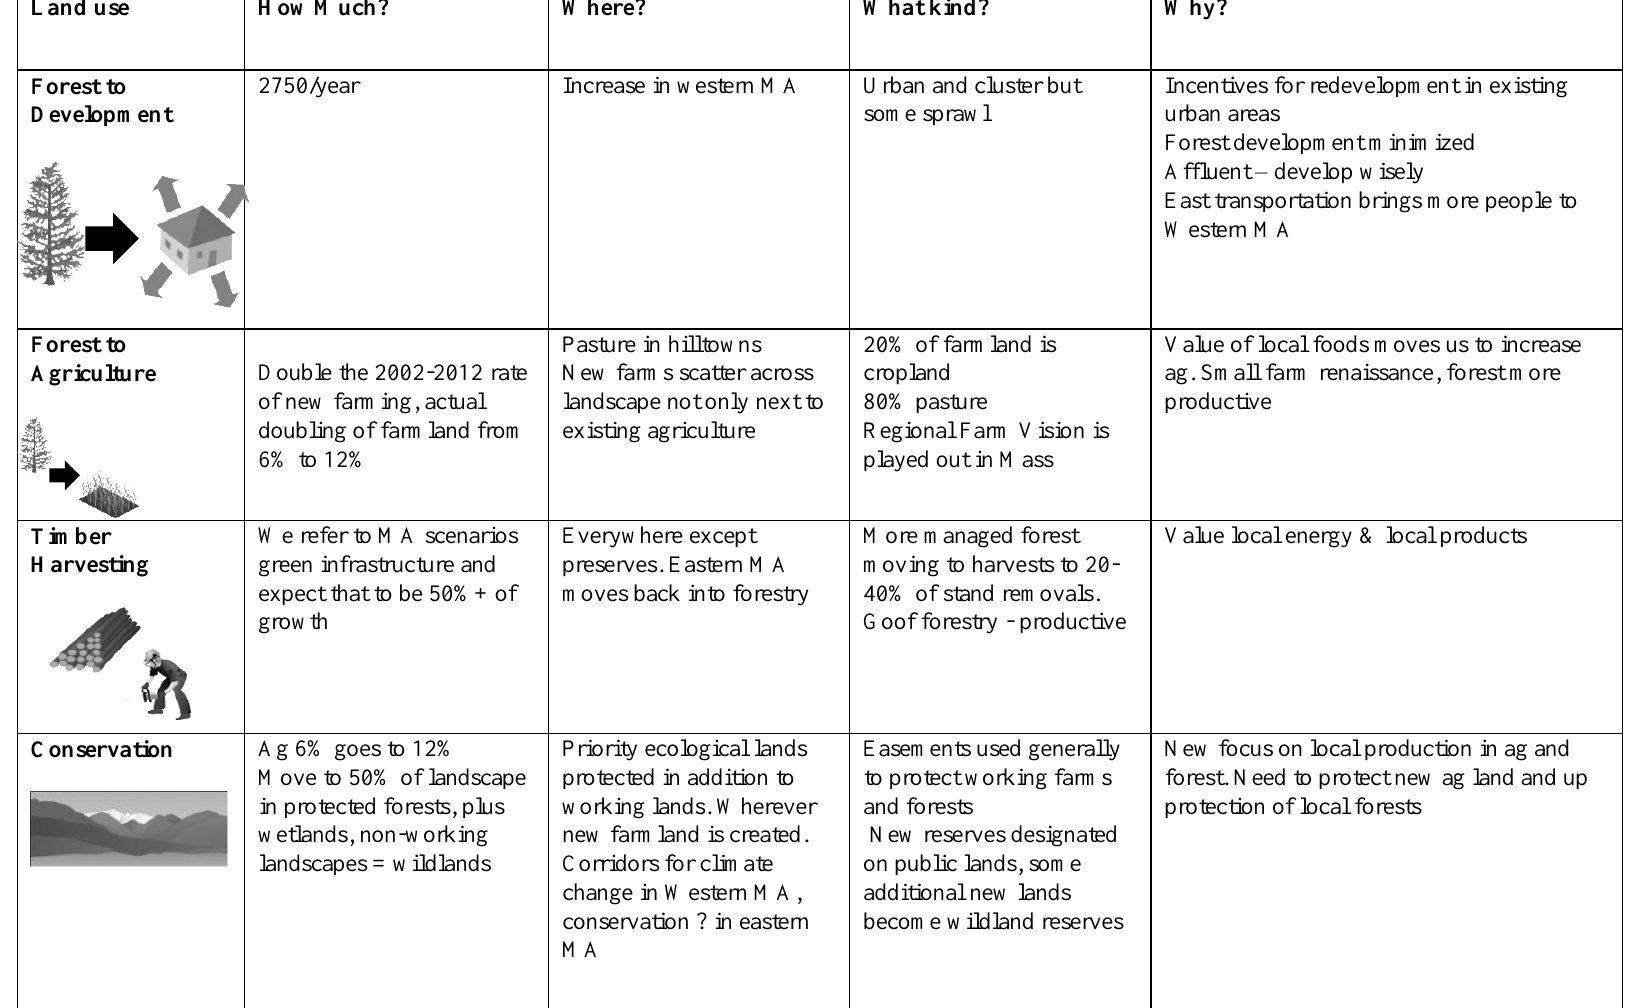
Table A2.6. Scenario 2: Global Village Land